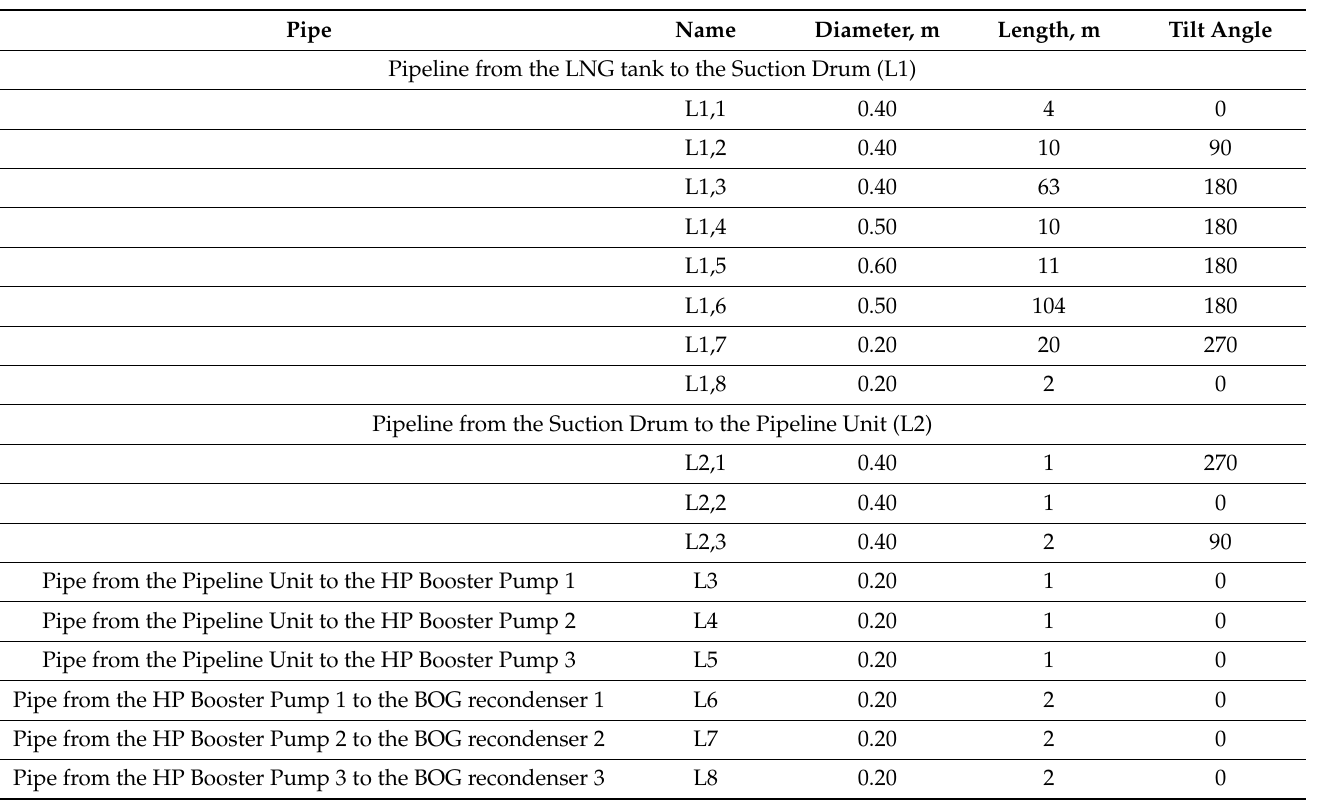
Table 3. Specification of FRSU LNG transportation pipelines system.